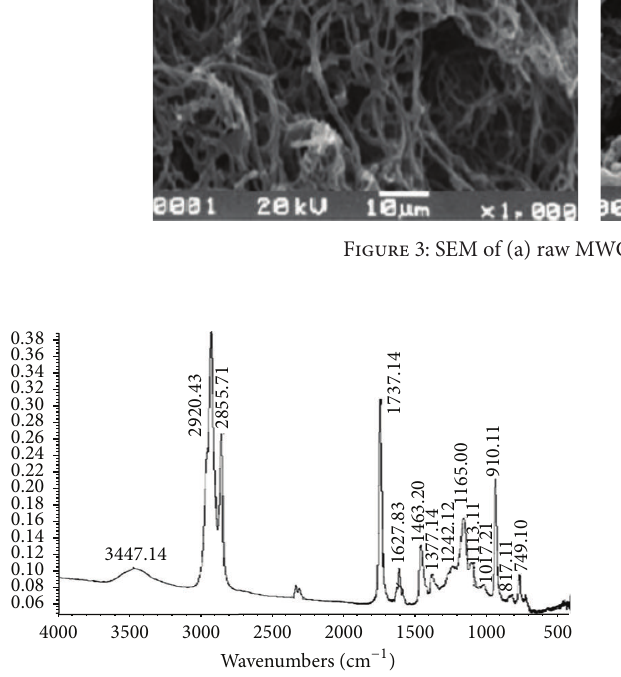
Figure 4: FTIR spectrum of VER/EP blend (40:60